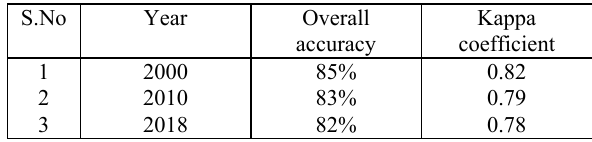
Table 1. Values of overall accuracy and kappa coefficient